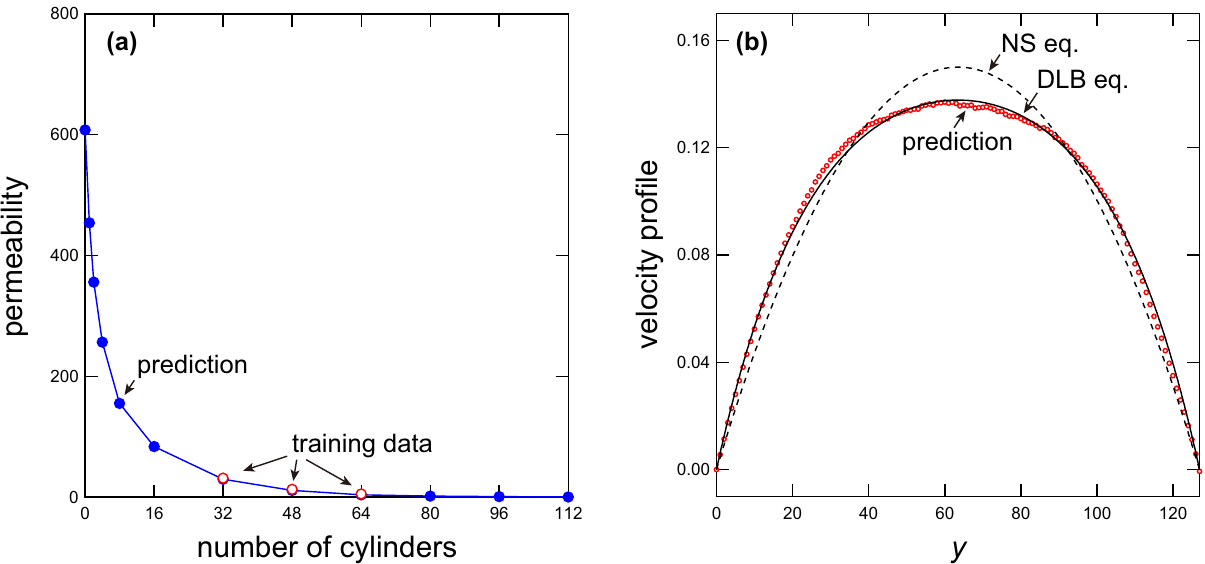
Figure 6. ( a ) Permeability k as a function of the number of cylinders. Red open and blue closed symbols indicate the permeabilities obtained from the training data and prediction, respectively. ( b ) Velocity profile predicted using the present model when the cylinders are not present (red symbols). The solid line indicates the velocity profile obtained using the DLB equation with the permeability k indicates the velocity profile obtained using the NS equation (see Eq.